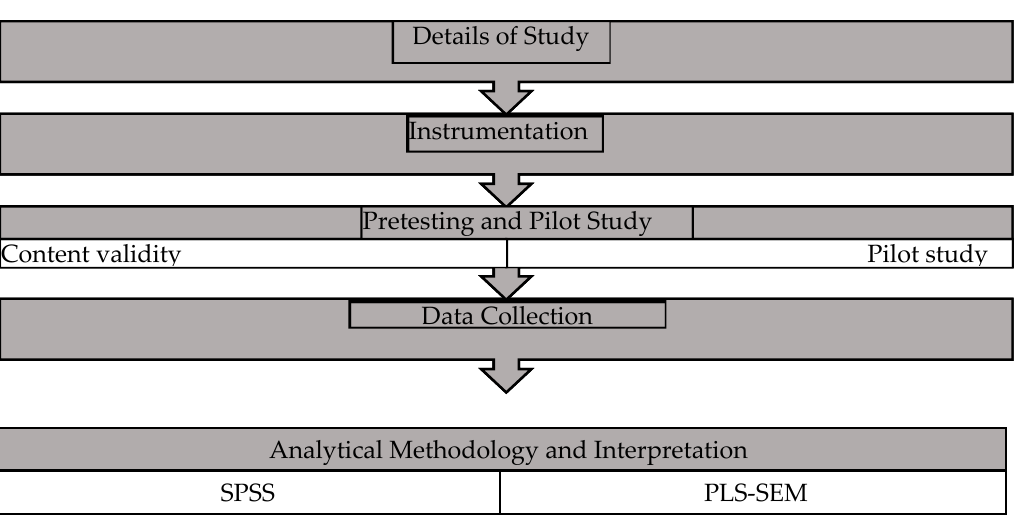
Figure 6. Flow Chart for Quantitative Research Design. Source: Sekaran and Bougie (2010, p. 68).